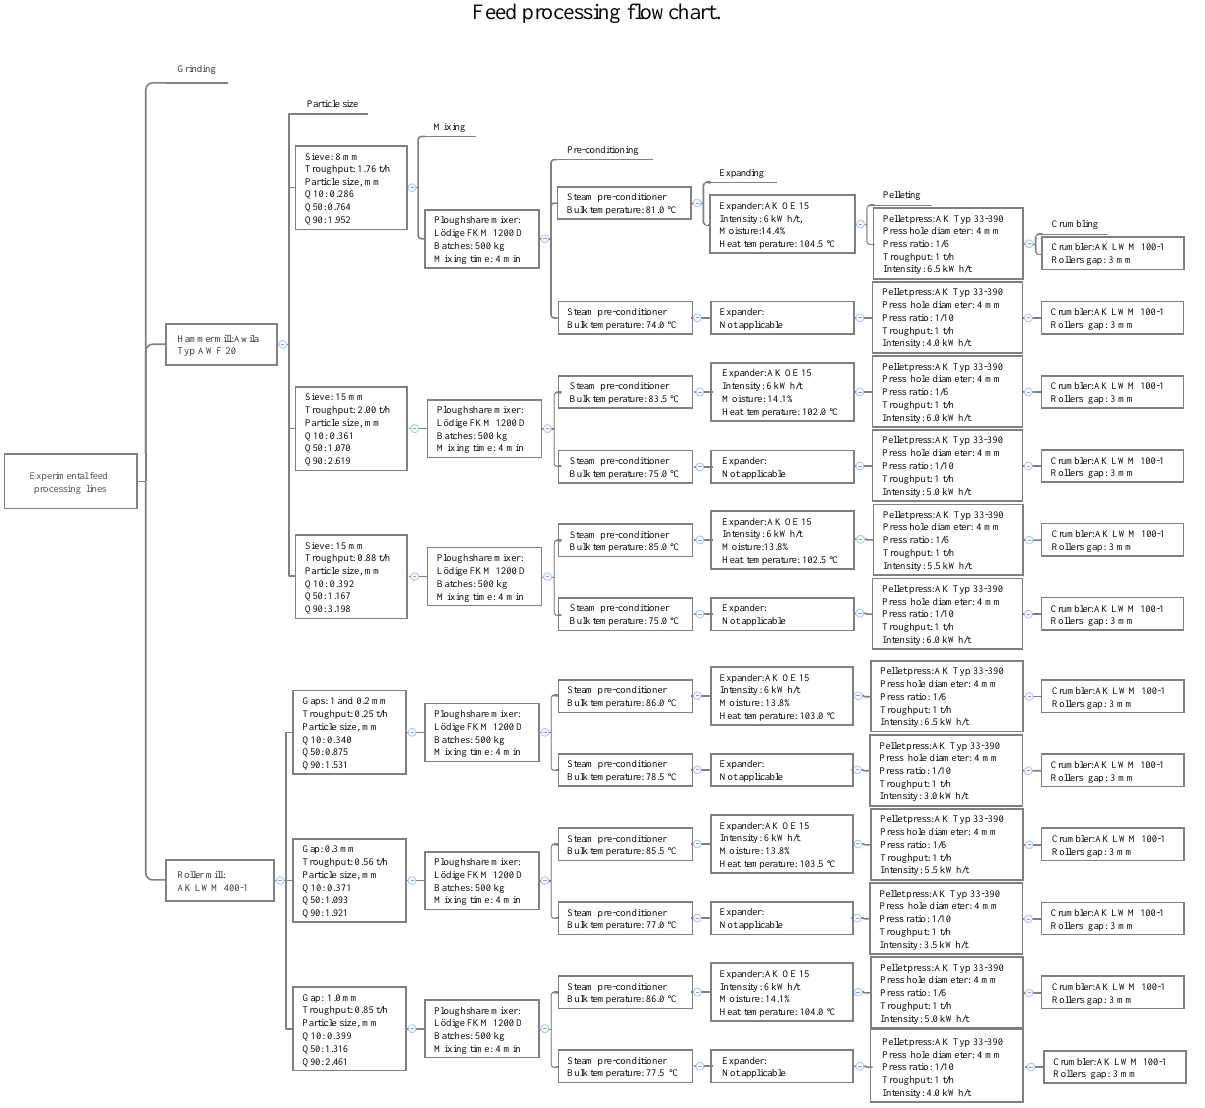
Figure A1. Processing lines for the different processing steps during compound feed production.